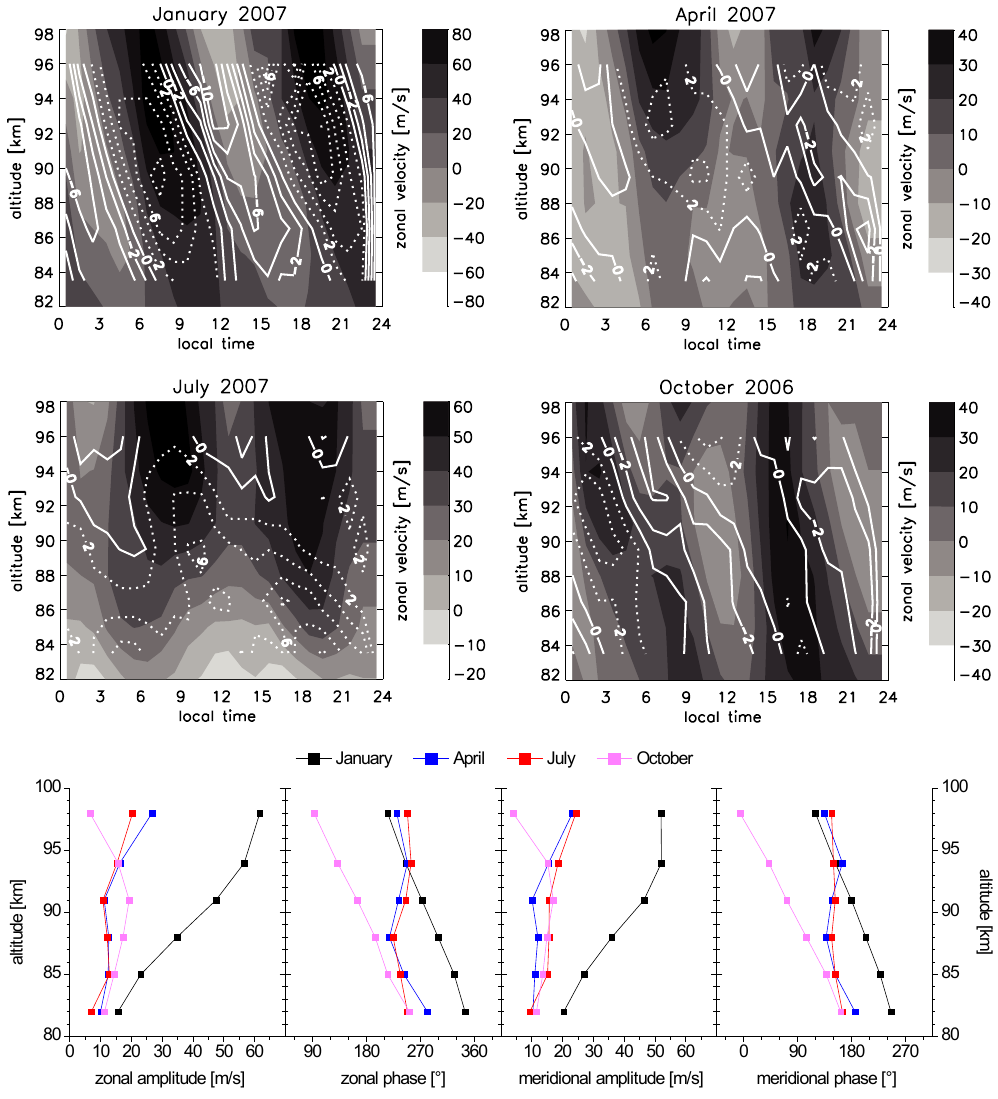
Fig. 3. Monthly mean zonal winds over Collm, for 4 seasons (color code) and vertical zonal wind shears derived from these winds (contours). Note the different scaling of the ordinate in the respective panels. In the lowermost panels amplitudes and phases of the zonal and meridional SDT are shown for 4 months. The phases refer to local